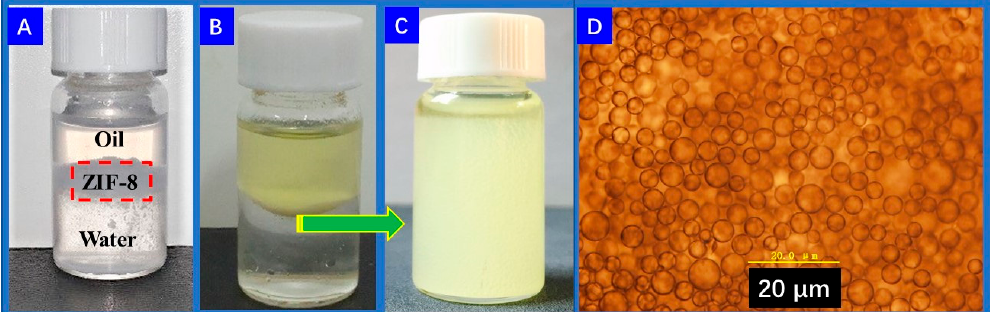
Figure 4. Photographs of the water/ZIF-8/ethyl acetate system ( A ) and water/ZIF-8/2-nitrobenzaldehyde and ethyl acetate system ( B ) without stirring. Appearance ( C ) and corresponding optical microscopy image ( D ) of Pickering emulsions stabilized by ZIF-8.